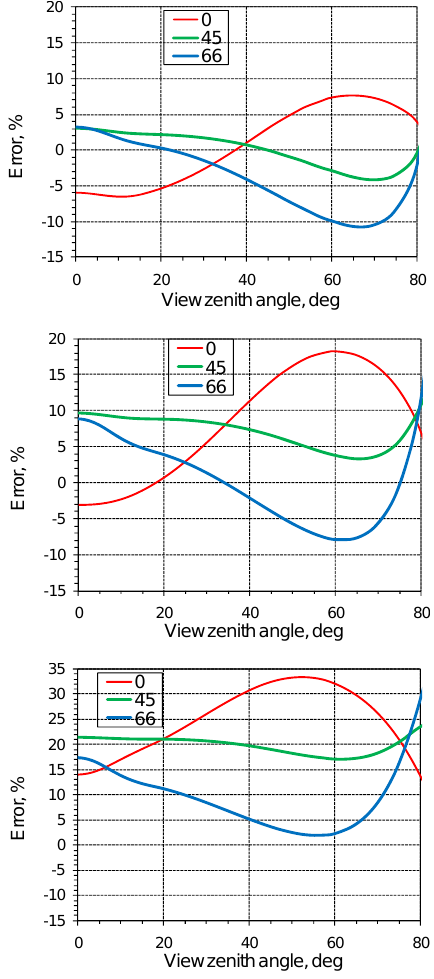
Fig. 4. Errors of the MSA computations of the reflectance from layers with Continental aerosol at normal incidence dependent on the view zenith angle at the layer optical thickness equal to 0.2 (top), 0.5 (middle), 1.0 (bottom). Data for different cut angles are given in red (0 ◦ ), green (45 ◦ ) and blue (66 ◦ ). π R p(θ) sin θ d θ ( 1 / 2 ) 0